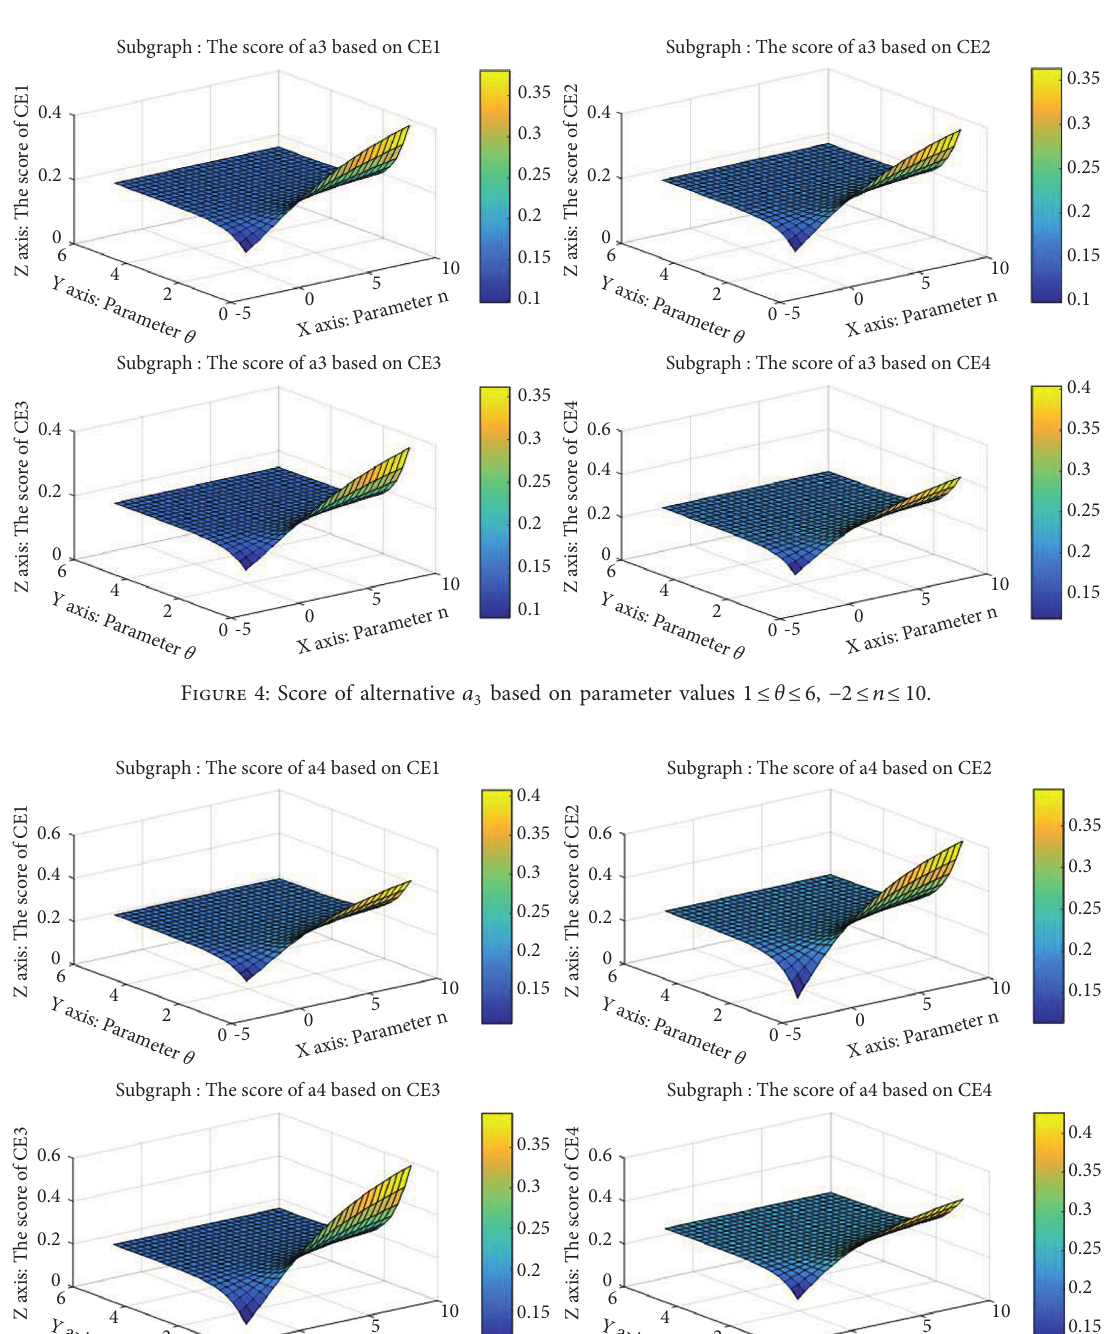
based on parameter values 1 ≤ θ ≤ 6, − 2 ≤ n ≤ 4